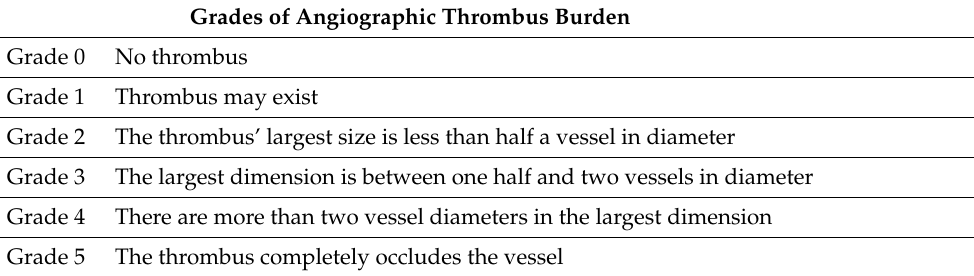
Table 1. Grades of Angiographic Thrombus Burden. Grades of Angiographic Thrombus